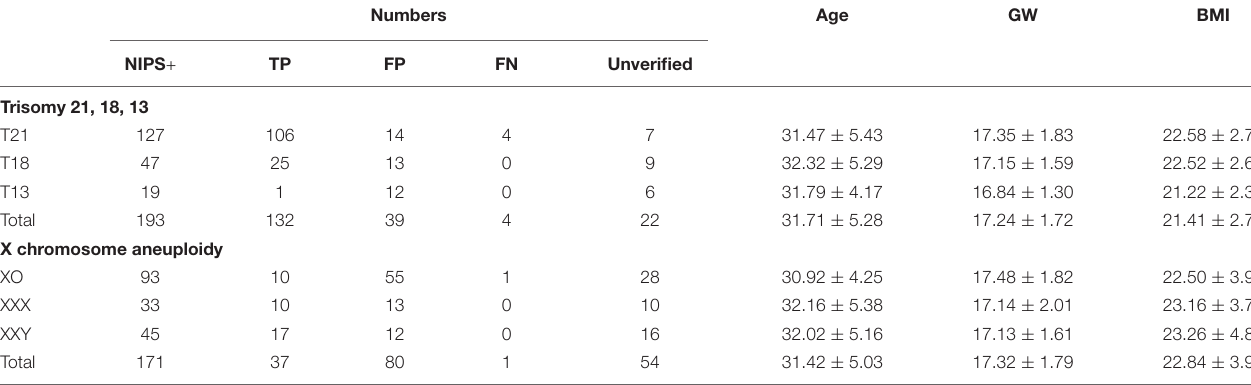
TABLE 1 | Numbers and maternal characteristics of pregnancies with noninvasive prenatal screening (NIPS) positive